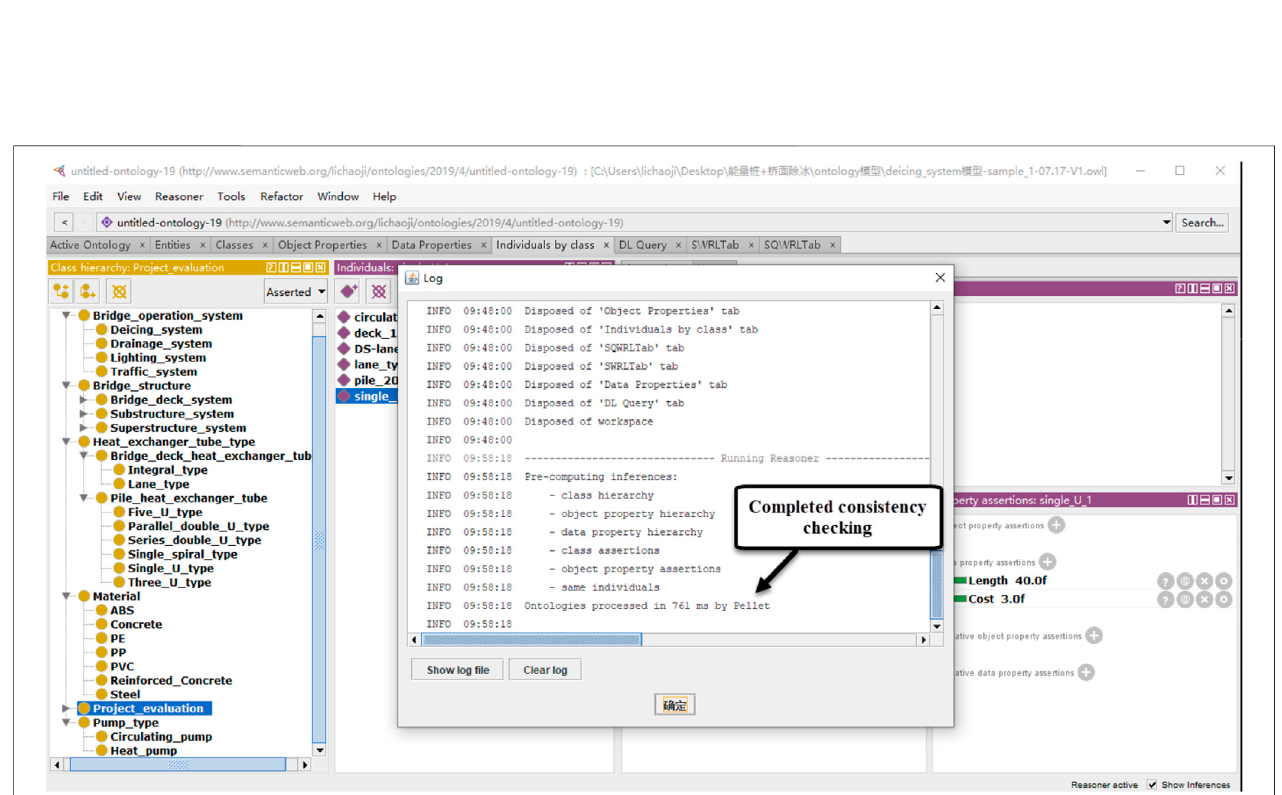
FIGURE 7 | The log of running pellet plug-in for completed consistency checking of the OntoBDDS.